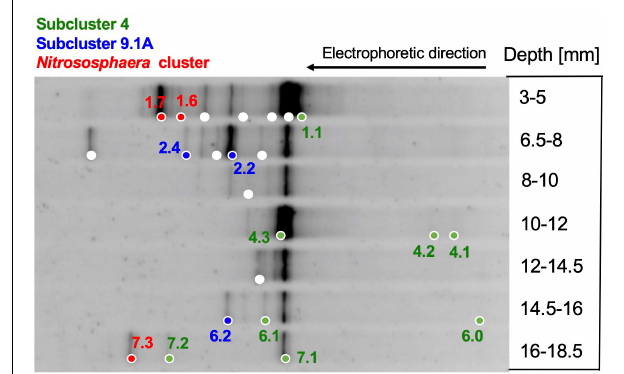
FIGURE 4 | DGGE analysis of archaeal ammonia monooxygenase alpha subunit genes (amoA). DGGE bands are color-coded to match their phylogeny. Red, Nitrososphaera cluster; green, subcluster 4; blue, subcluster 9.1A (based on Pester et al., 2012). No amplifiable archaeal amoA genes were found below ca. 2 cm depth.